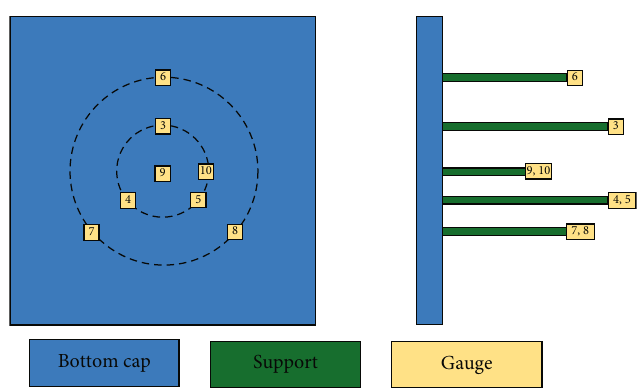
Figure 11: PVDF piezoelectric gauges.